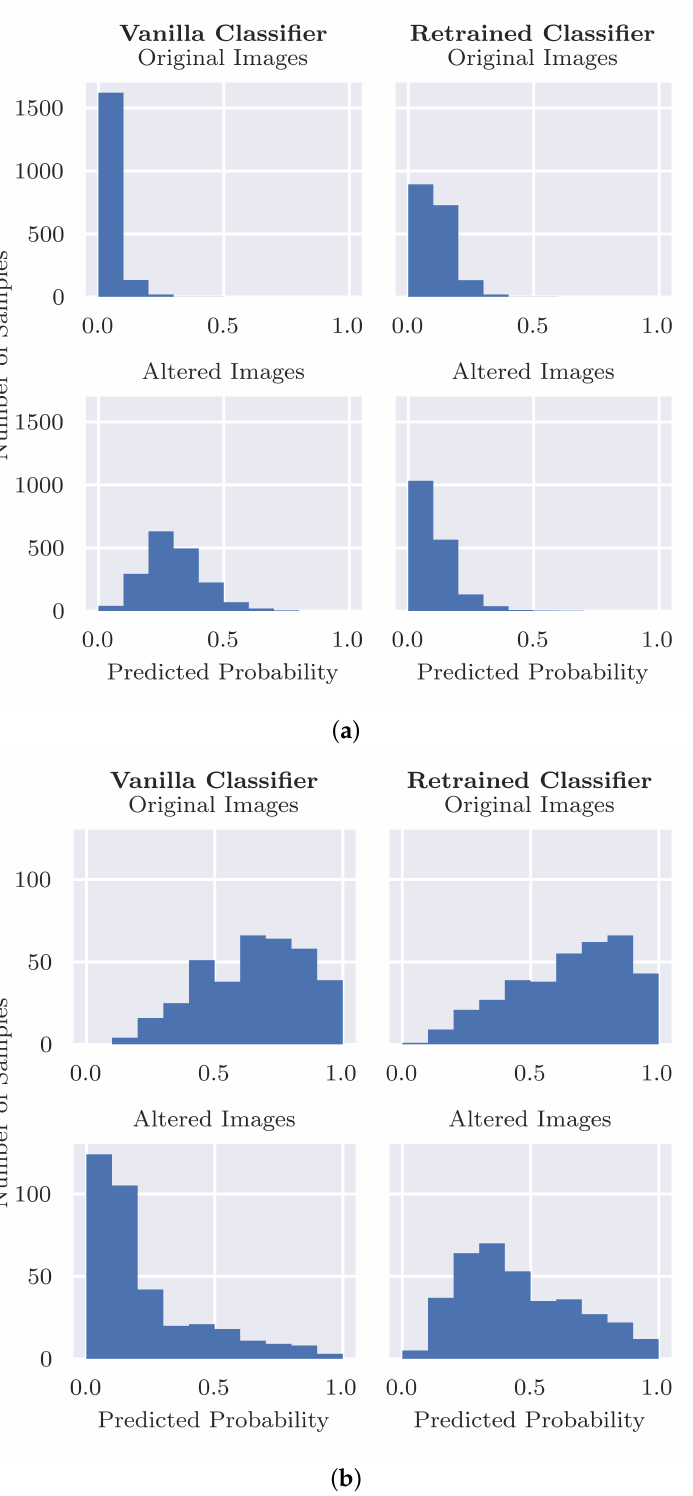
Figure 6. Predictions P ( malignant | x ) by the classifiers before (Original) and after (Altered) removal resp. insertion. ( a ) Inpainting the coloured patches in benign images. Only images with a patch are included; ( b ) inserting coloured patches into images of malignant